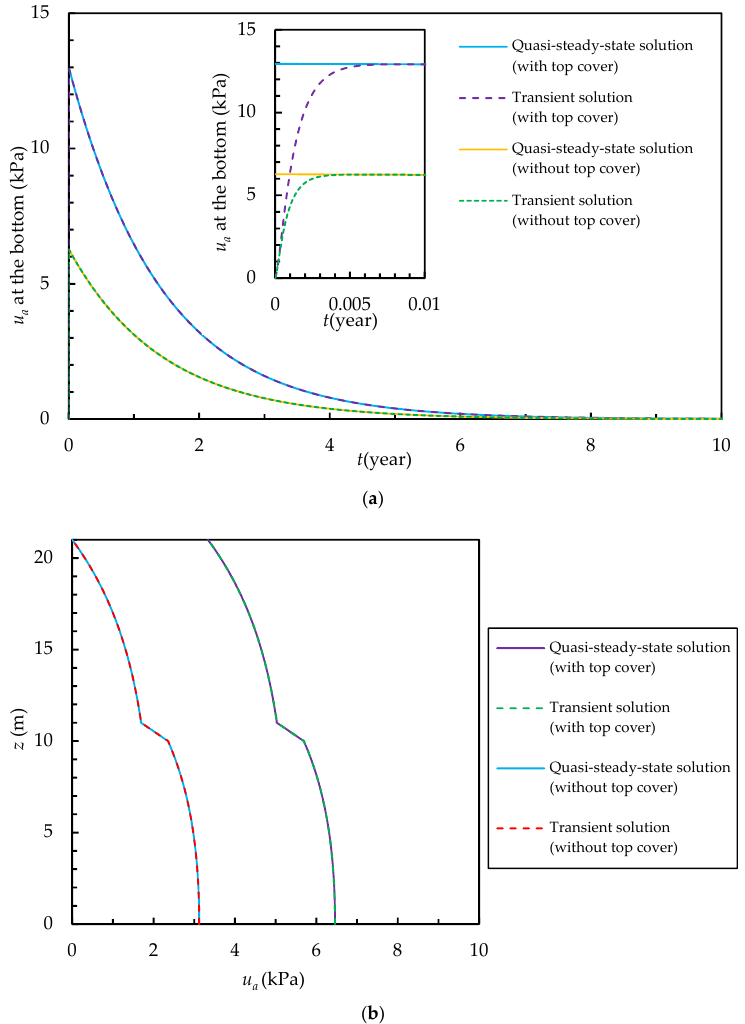
Figure 5. Gas pressure calculated by the transient analytical solution and the quasi-steady-state analytical solution. ( a ) Gas pressure changing with time. ( b ) Gas pressure changing with depth at t = 1 year.